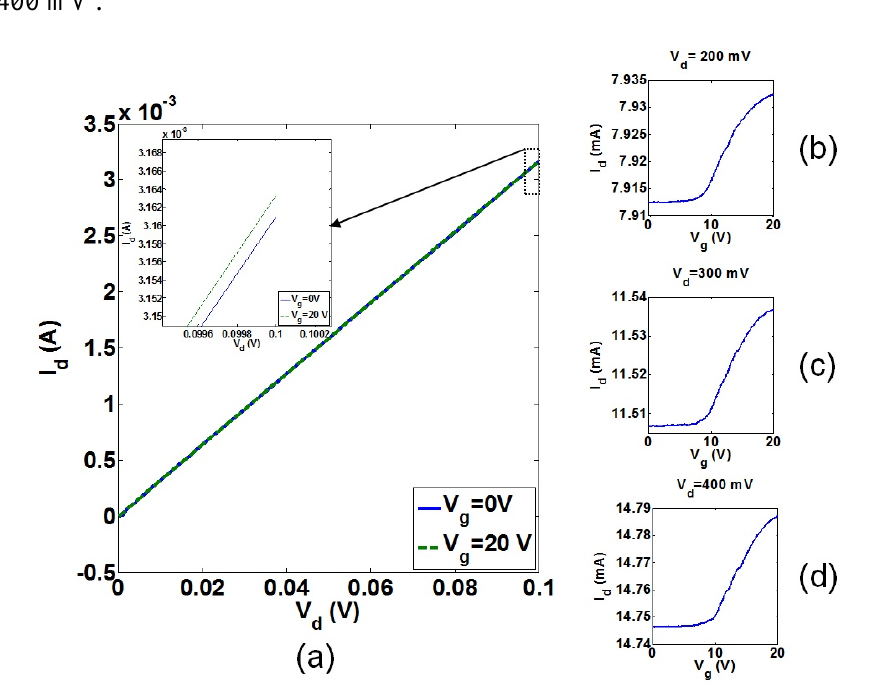
- V characteristic at d d = 200 mV, ( c ) V = 300 mV, d d